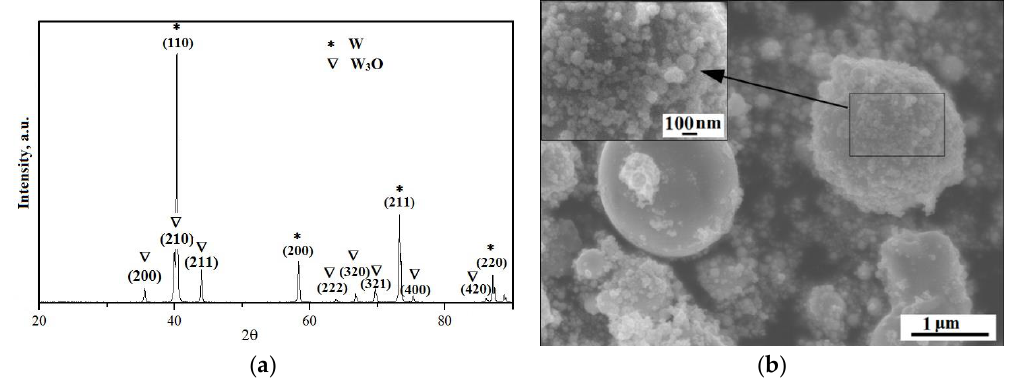
Figure 1. W nanopowder: X-ray difraction patterns ( a ); SEM-image ( b ).